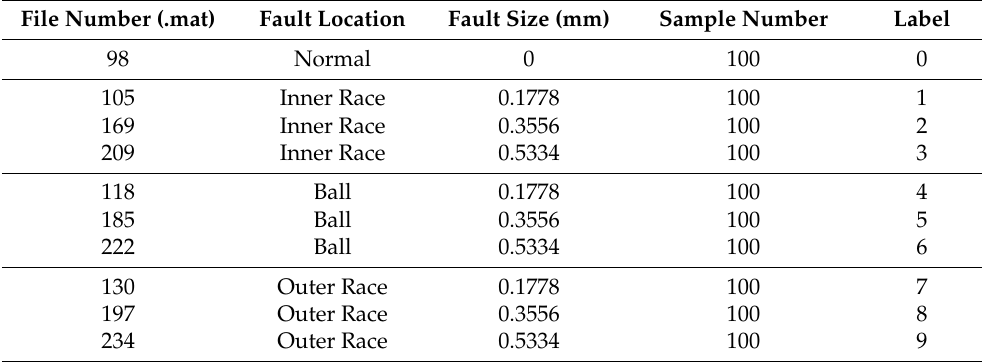
Figure 4. The CWRU fault simulation test platform. Table 2. CWRU dataset classification